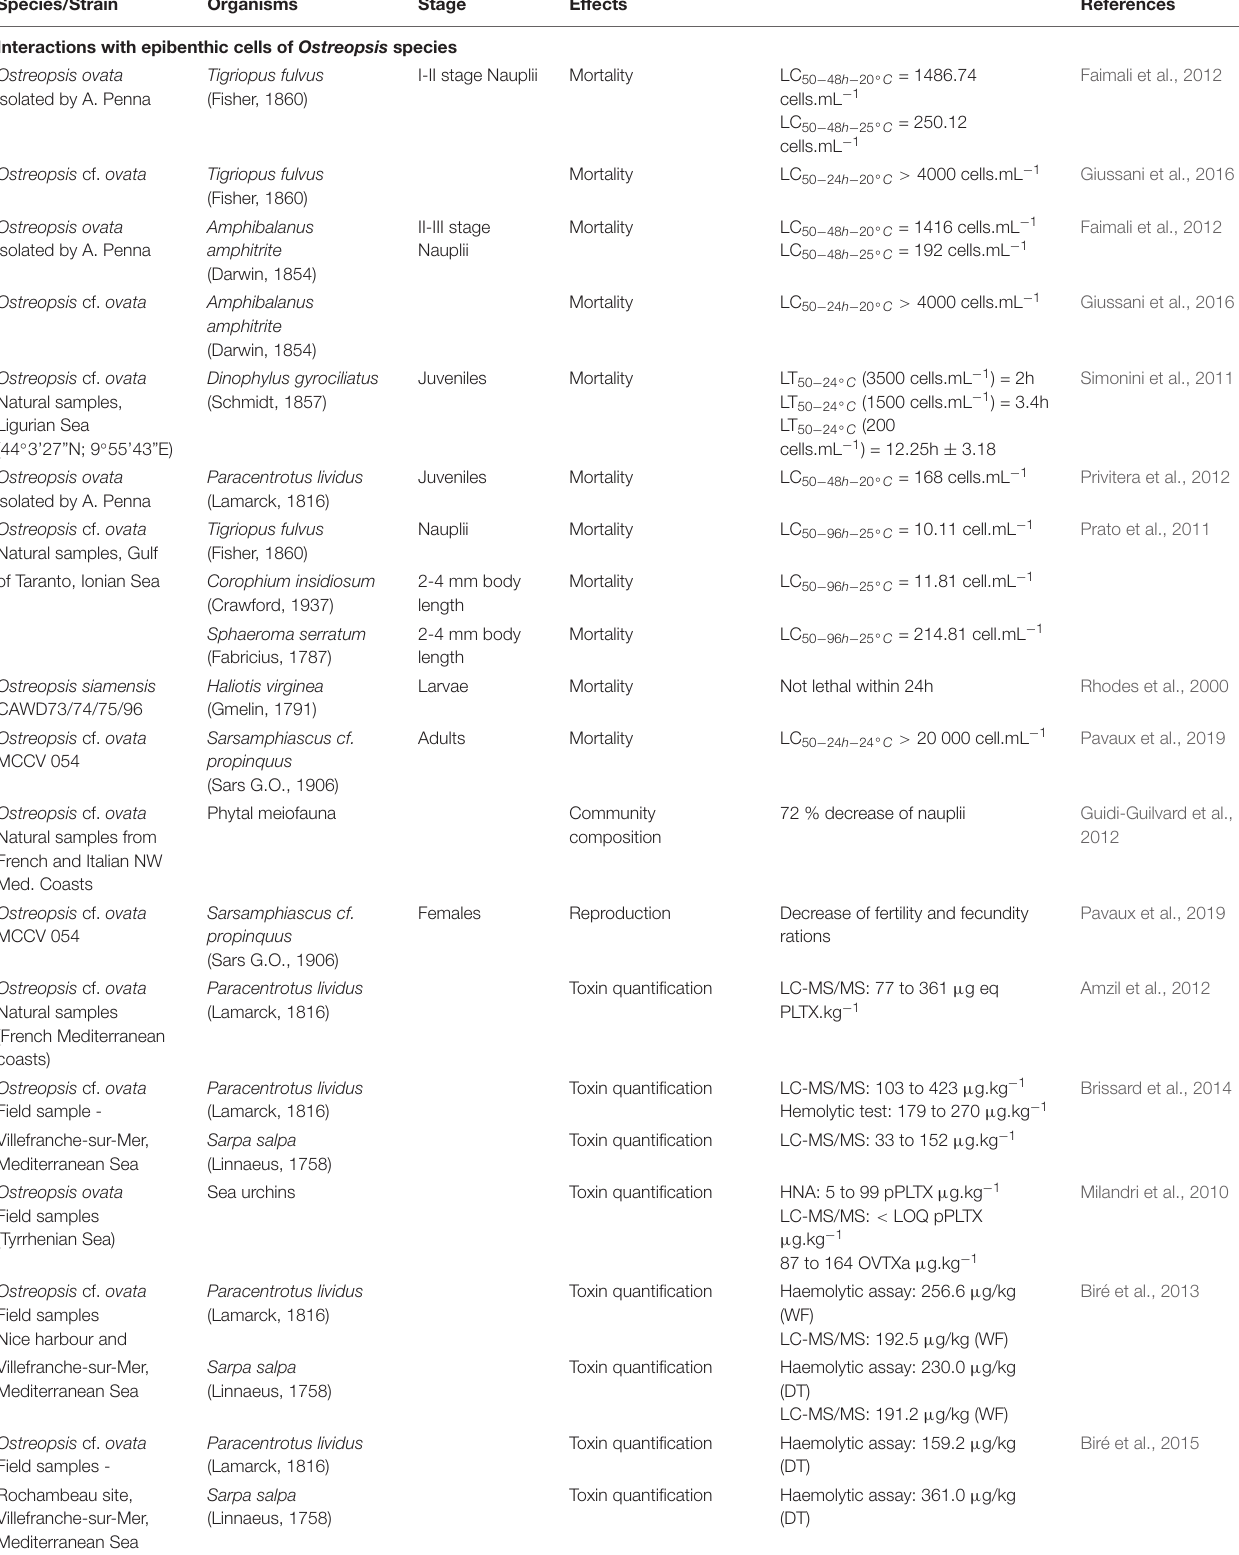
TABLE 3 | Noxious effects of direct interaction of Ostreopsis species on different